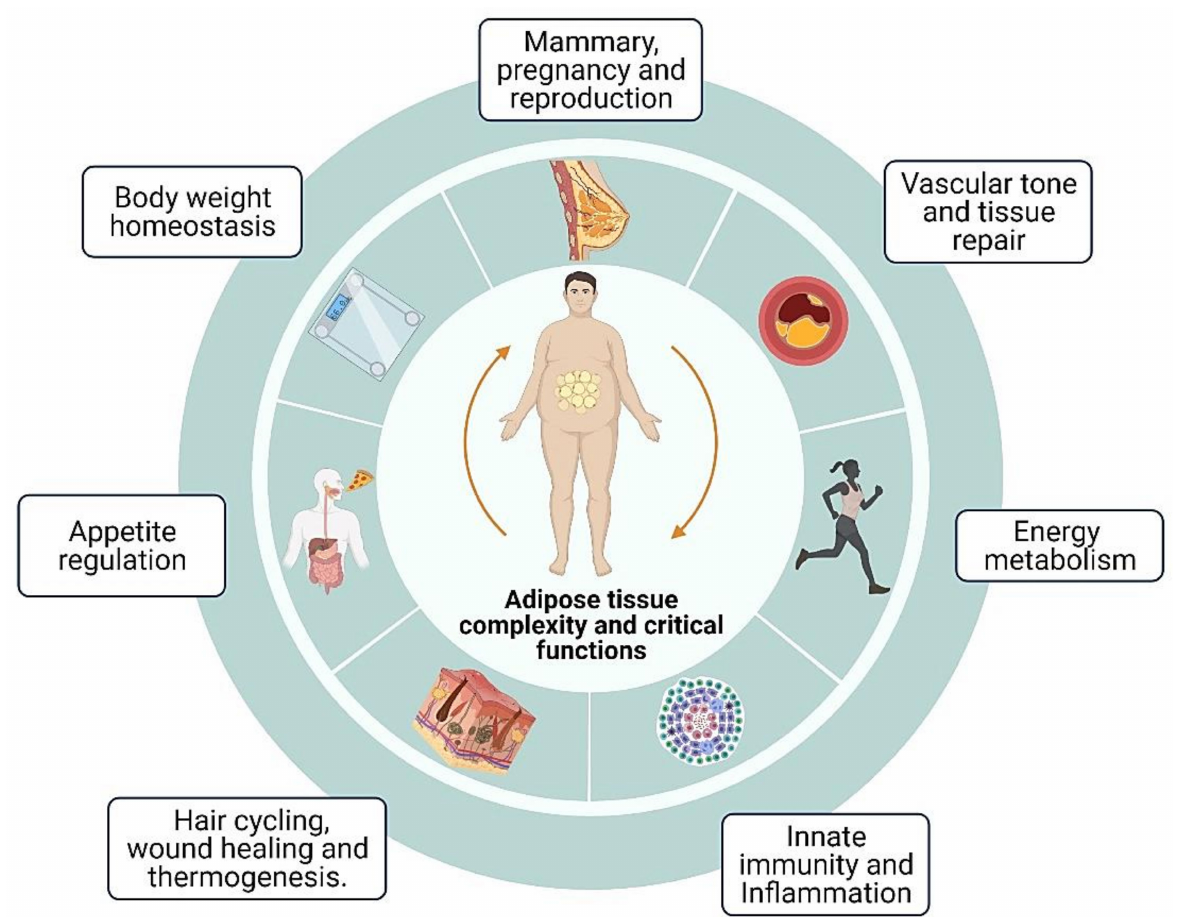
Figure 1. Adipose tissue in mammals participates in various body biological functions. Representa- tion of the main physiological process involved. Biorender web-based software was used to create the figure (License Number